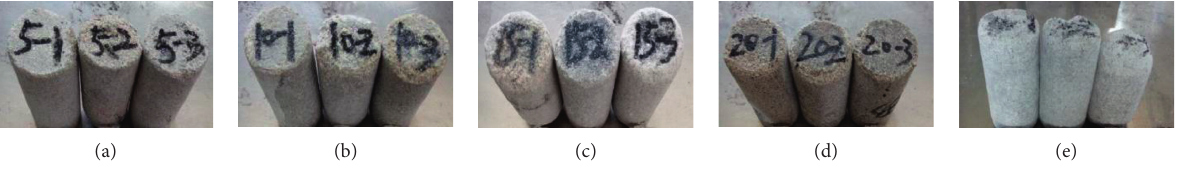
Figure 4: Apparent properties of the feldspar sandstones (group B) after a salt-rock dry-wet cycle. (a) 5 T. (b) 10T. (c) 15T. (d) 20T. (e) 25T.